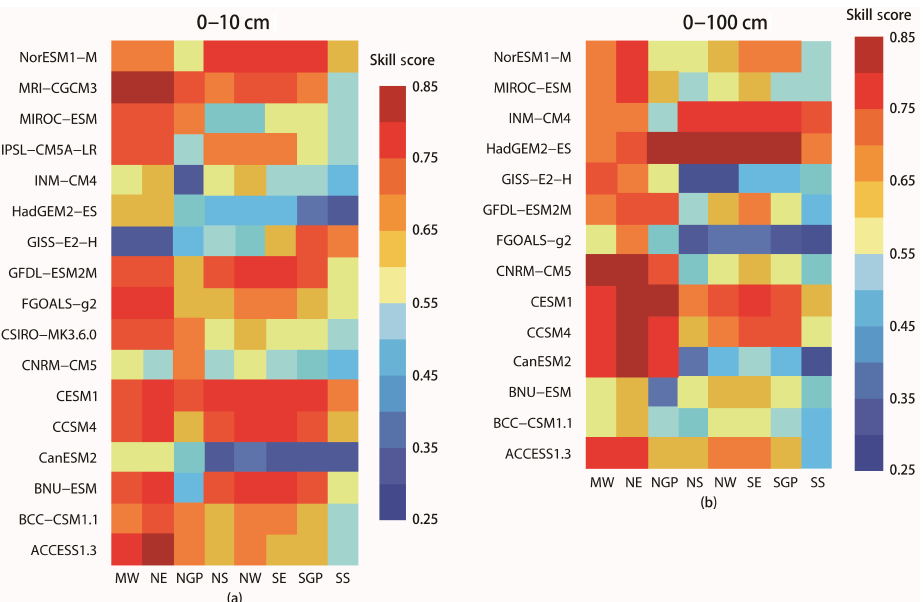
Figure 9. Comparison of CMIP5 models with in situ observations over eight subregions based on Taylor skill scores: (a) 0–10cm soil moisture and (b) 0–100cm soil moisture.